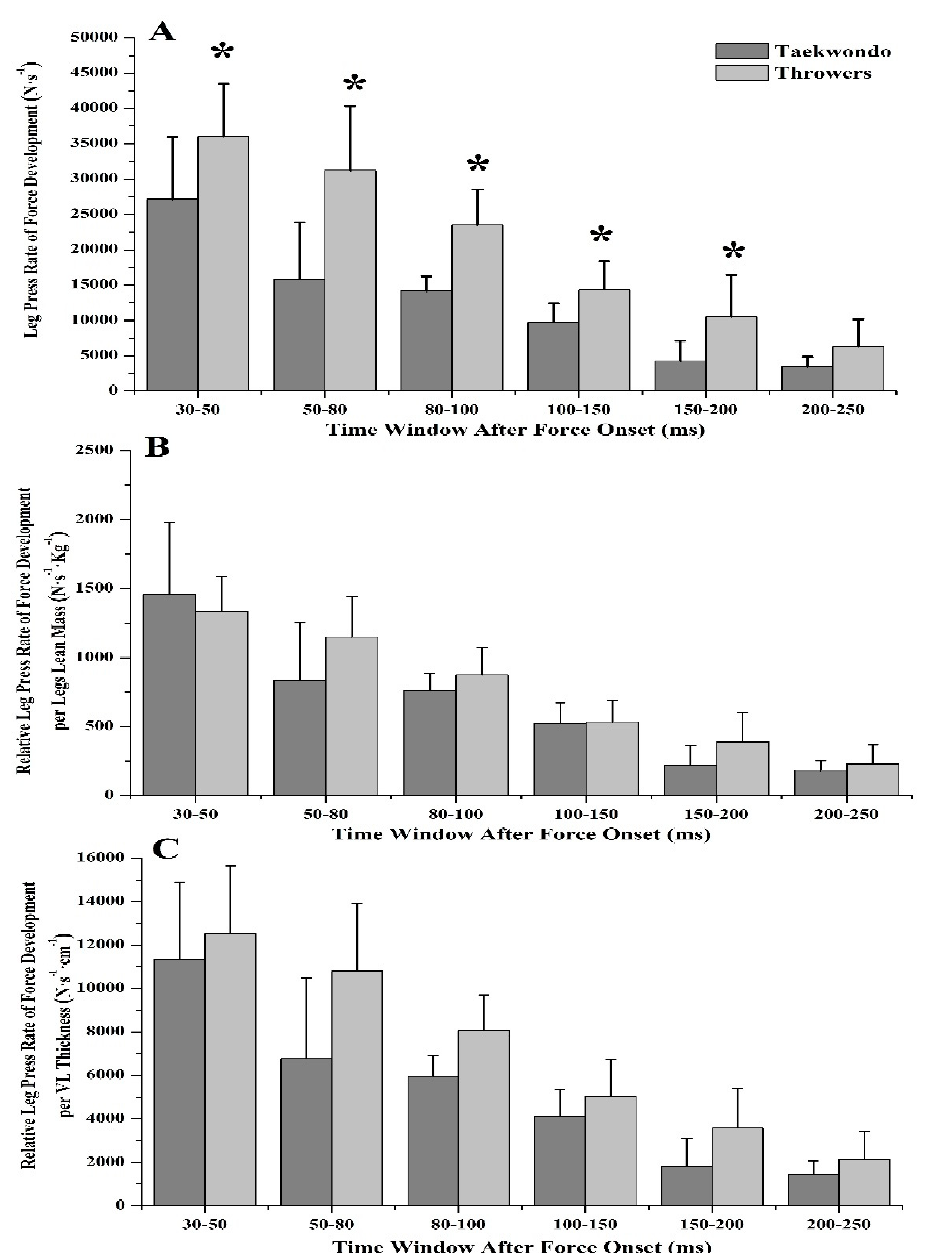
Figure 2. Leg press sequential rate of force development (SRFD) for taekwondo athletes (dark grey) and track and field throwers (light grey). ( A ) Leg press SRFD in absolute values. Track and field throwers had greater SRFD than taekwondo except during for the 200–259 ms time window where no difference exists. ( B ) Leg press SRFD relative to lower body lean mass. No significant difference was found between taekwondo and throwers. ( C ) Leg press SRFD relative to VL muscle thickness. No significant difference was found between taekwondo and throwers (* p < 0.05).